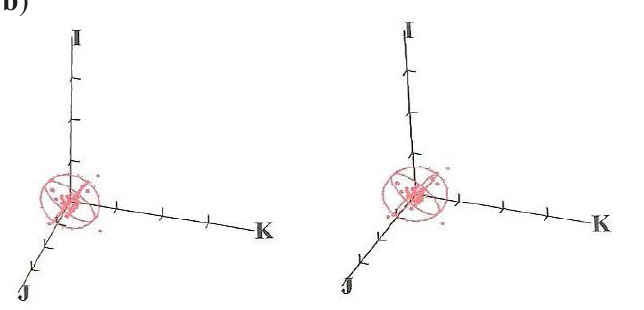
Figure 1: Stereo-pair scatter plots of symmetric dioptric power space for the anterior ( a ) and posterior ( b ) corneal keratometry for Subject 1. The three mutually orthogonal axes labelled I , J and K are the stigmatic, ortho-antistigmatic and oblique antistig- matic axes. The origin for each stereo-pair represents the sample mean concerned. The axes have ticks at intervals of 0.25 D and the same applies to Figures 2-5. Each dot represents one meas- urement of the dioptric power of the anterior ( a ) or posterior ( b ) corneal surface of the eye. The stereoscopic nature of the graph is appreciated by letting the eyes drift into an exo-posture to form a single 3-dimensional percept.